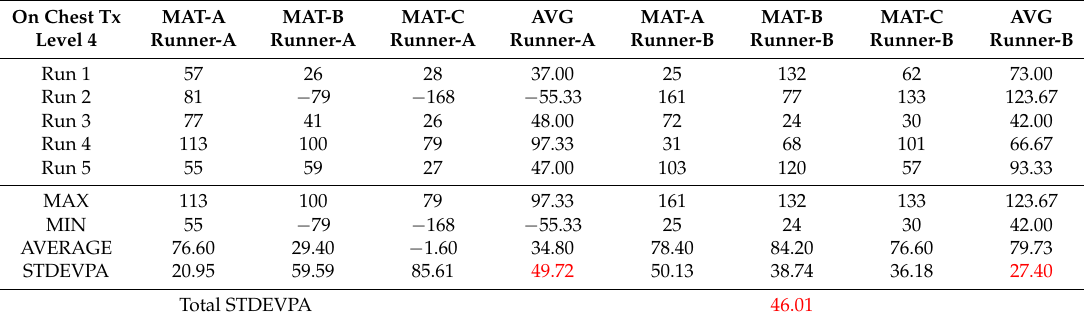
Table 14. The experiment in which two runners with a BLE Tag on their respective chests ran through three sets of MAT.